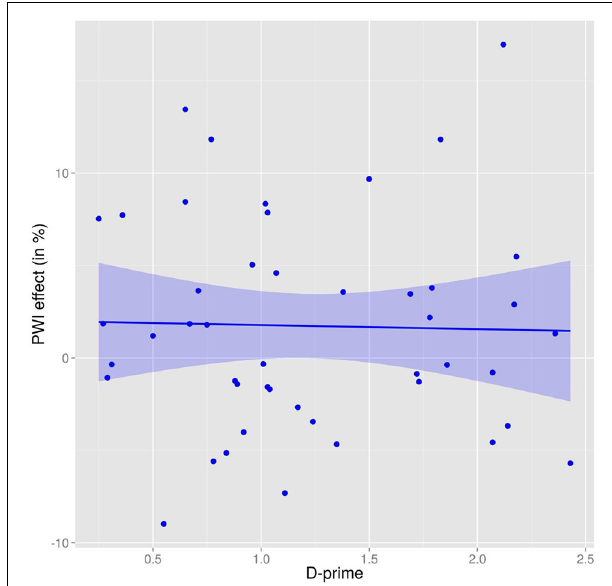
FIGURE 1 | Picture word interference effect (masked, for “categorically related” distractors; as percent relative to unrelated baseline) dependent on d-prime in lexical decision task. Dots represent individual